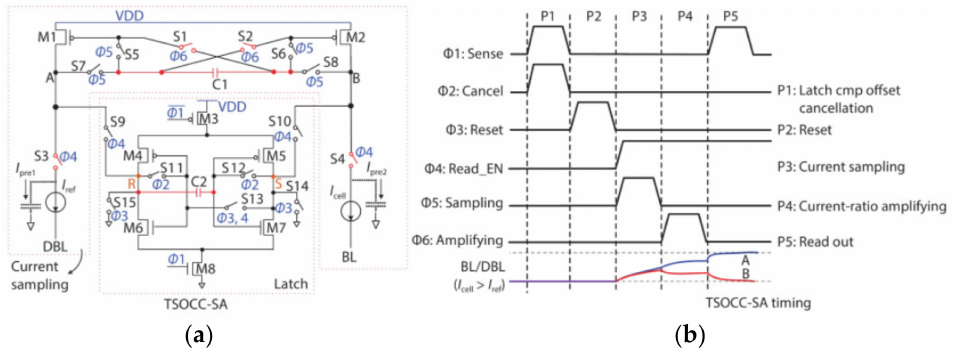
Figure 13. ( a ) The scheme of TSOCC-SA; ( b ) the simulation of TSOCC-SA